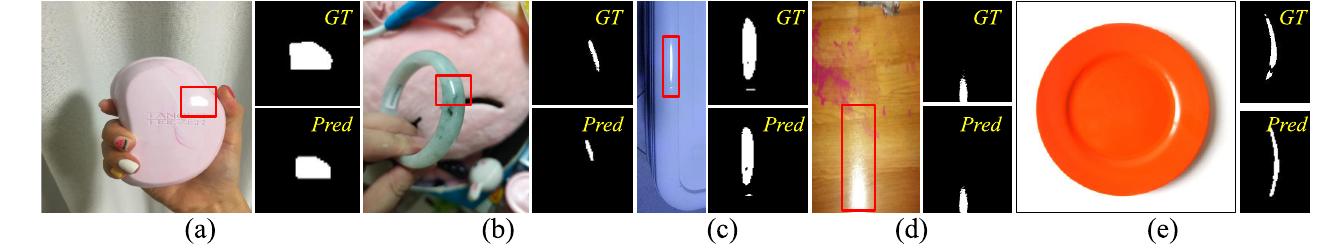
Figure 8. Zoomed-in ground truth (GT) and prediction (Pred) views of the marked sections in RGB images from [57]. SpecSeg network is successfully able to detect regions that are ( a ) on light-coloured objects, ( b ) small in size, ( c ) in multiple blocks with cavities inside specular regions, ( d ) clipped around the edges of the image, ( e ) detect specularity correctly from images on a white background.